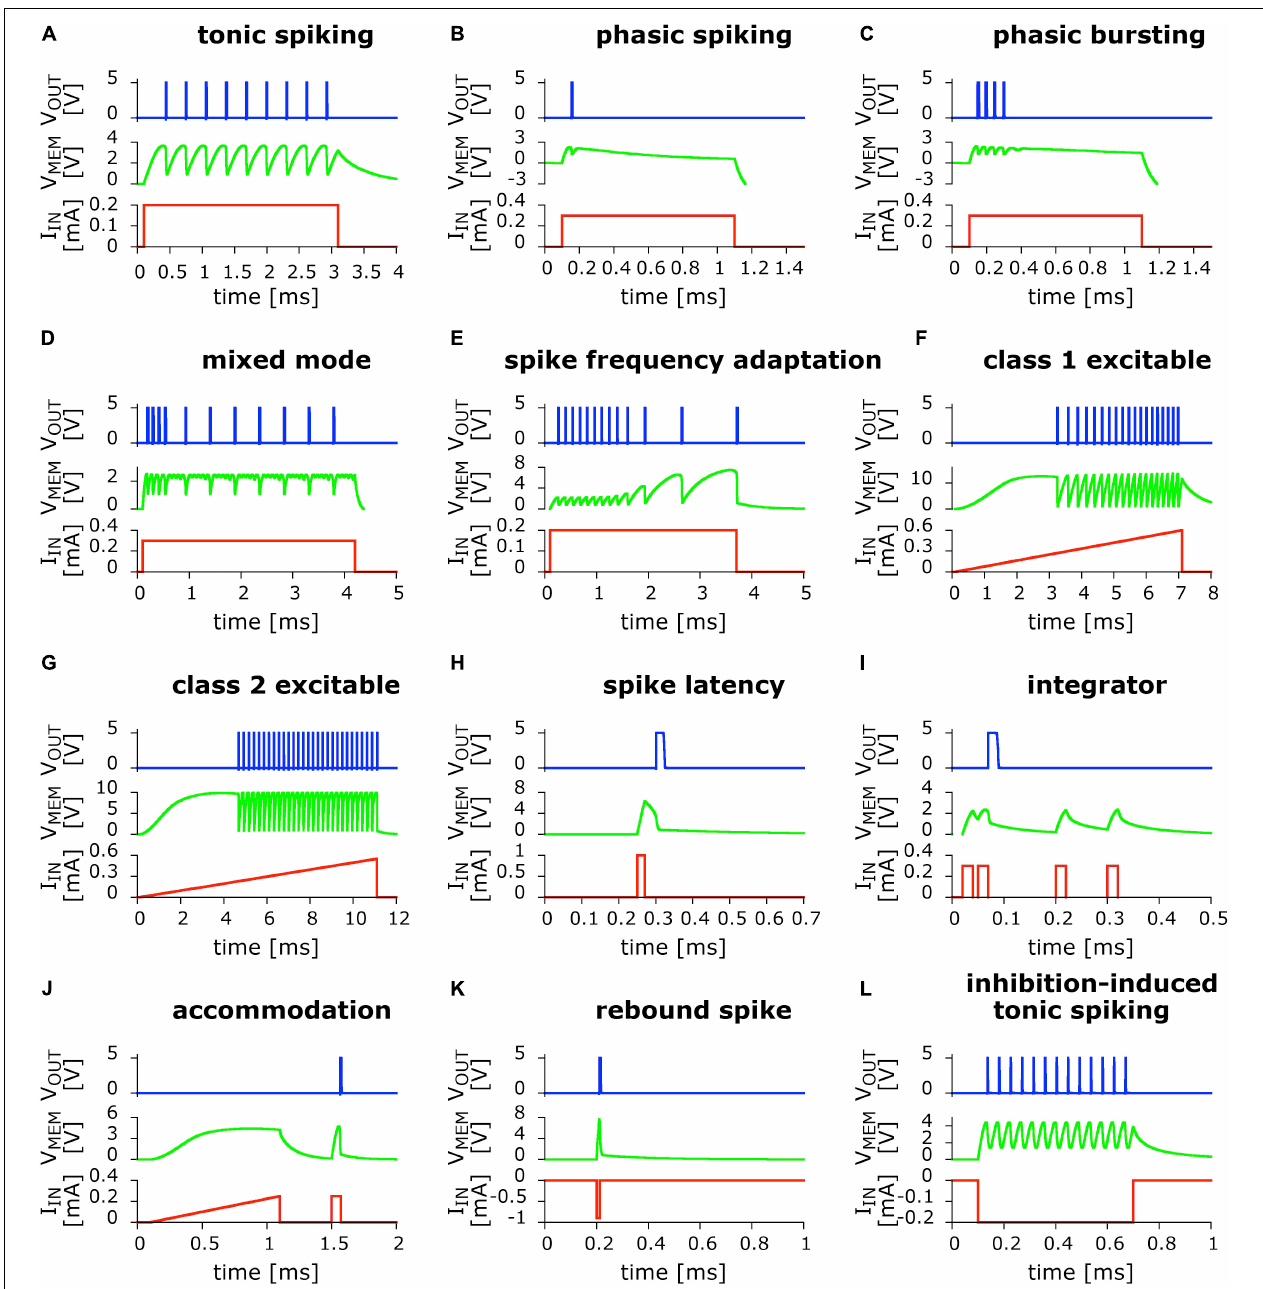
FIGURE 2 | Twelve biologically relevant behaviors obtained from numerical simulations of small variants of the basic UCN LIF circuit, using the LTspice code. In red line is the applied input current excitation I IN as function of time. In green line is the “membrane” voltage V MEM at capacitor C 1 . In blue line is the output voltage V OUT that shows the dynamical spiking behavior. From left to right and top to bottom: (A) Tonic spiking; (B) phasic spiking; (C) phasic bursting; (D) mixed (burst then spiking); (E) spike frequency adaptation; (F) class 1 excitable; (G) class 2 excitable; (H) spike latency; (I) integrator; (J) accommodation; (K) rebound spike (negative polarity input); and (L) inhibition-induced (negative polarity input) tonic